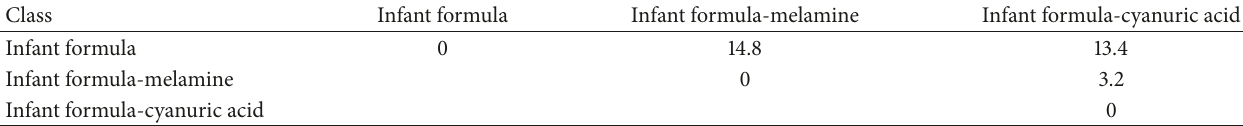
Table 4: Interclass distances of the different populations derived from SIMCA.